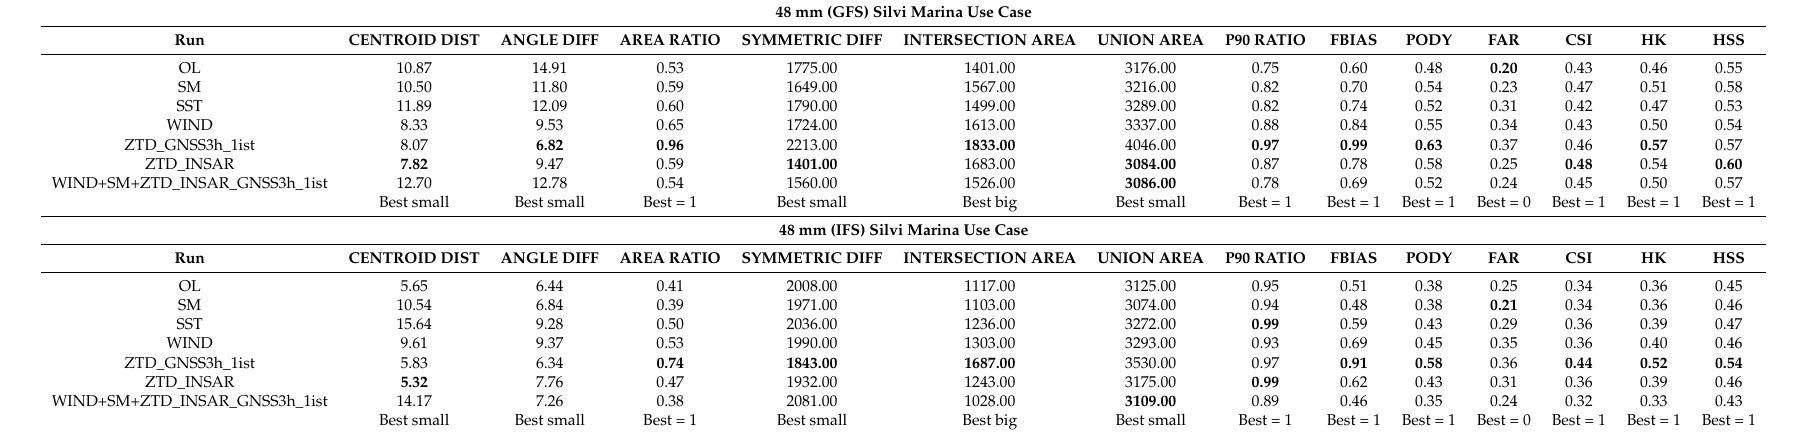
Table A8. Spatial and statistical indices calculated through MODE (48 mm rainfall depth threshold) to evaluate the sensitivity forecasts (driven by GFS and IFS respectively) with respect to the Open Loop run for the time interval 00UTC 15/11/2017–00UTC 16/11/2017. The best performance for each score is highlighted in